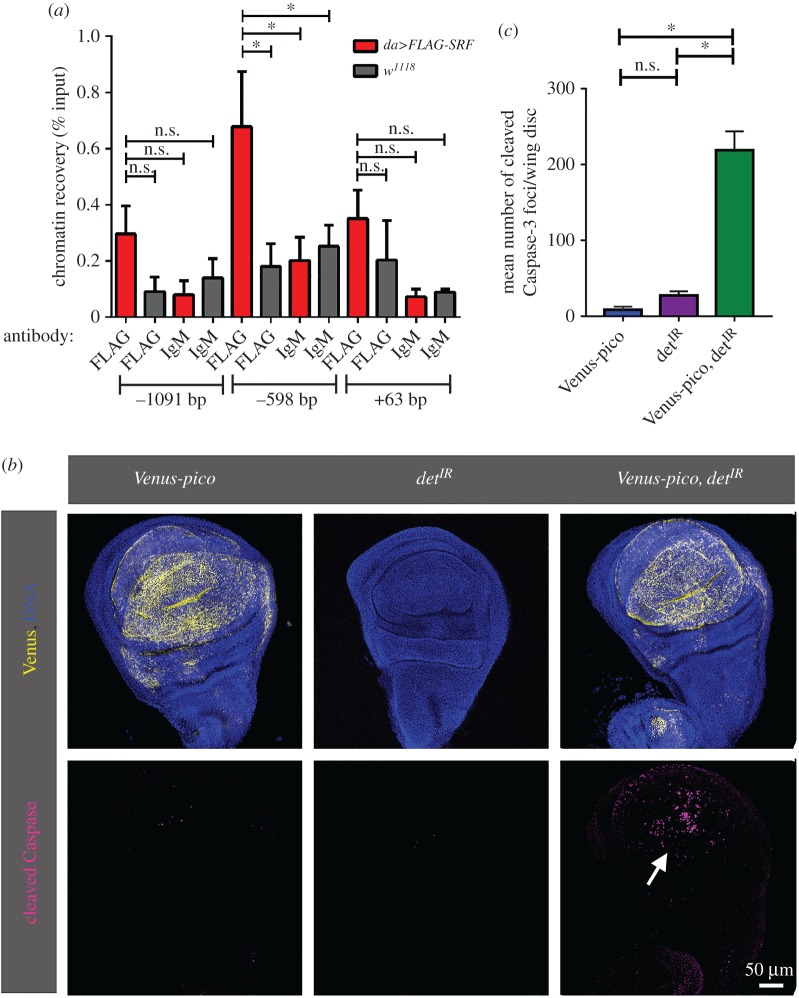
Deterin is a Mrtf/SRF target and suppresses apoptosis during pico-mediated tissue overgrowth. (a) A site 5′ of the transcription start site (TSS) of deterin binds FLAG-SRF. Chromatin immunoprecipitation (ChIP) analyses of three sites at the 5′ end of deterin containing a potential CArG box. Position of the CArG box relative to the TSS is indicated at the bottom. ChIP from third instar larval da>Flag-SRF and control larvae (da-GAL4 alone) was performed using monoclonal anti-FLAG and mouse IgM antibodies. Immunoprecipitated DNA was quantified by qPCR. For each genotype, percentage input is the amount of precipitated DNA relative to input DNA. Results are mean ± s.e.m. from three independent experiments. One-way ANOVA: *p < 0.05; n.s., not significant. Distance of sites from the TSS is indicated on the x-axis. (b) detIR induces cell death in wing discs co-overexpressing pico. Discs overexpressing Venus-pico (in yellow) are overgrown and show little cleaved Caspase-3-staining (in red); coexpression of detIR reduced tissue size and induced cleaved Caspase-3 in the centre of the wing pouch (arrow). (c) Quantitation of number of Caspase-3-positive foci in wing discs expressing Venus-pico or detIR, alone or in combination (mean ± s.e.m. from z-stacks of at least three wing discs). t-test: *p < 0.05, n.s., not significant.